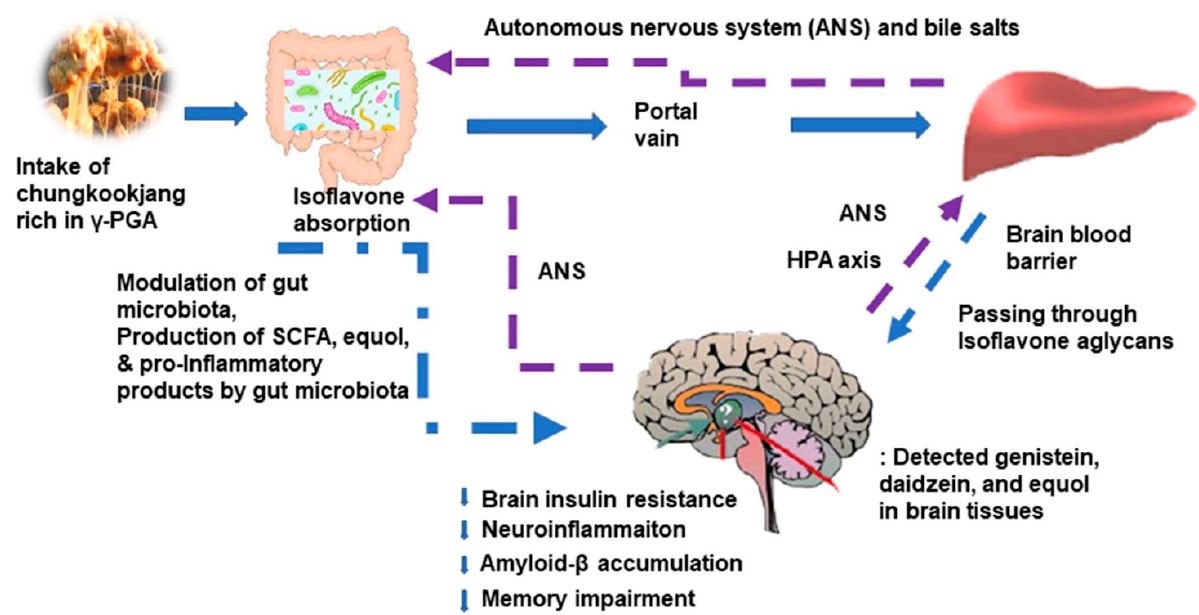
Figure 2. Potential action mechanism of chungkookjang in glucose metabolism and memory function. ANS, autonomous nervous system; HPA, hypothalamus–pituitary–adrenal; SCFA, short-chain fatty acids. Chungkookjang components directly influence glucose metabolism in the liver and brain, and they also indirectly affect them through the gut–microbiome–liver–brain axis. The improvement of glucose metabolism in the hippocampus reduces amyloid-b deposition, which decreases memory impairment. Thus, chungkookjang intake (about 20–30 g/day) protects against and partially alleviates type 2 diabetes, Alzheimer's disease, and post-stroke symptoms.